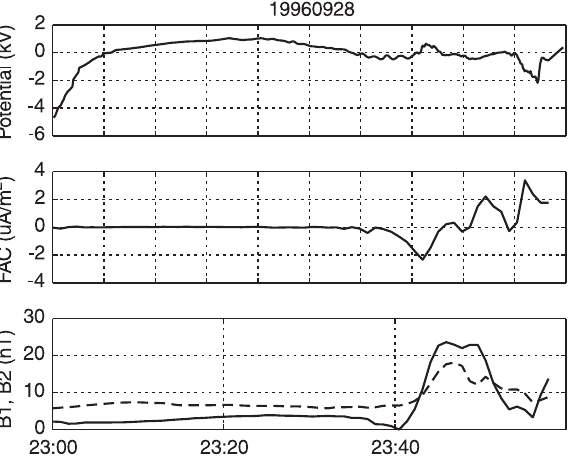
Fig. 3. Event 960928 23:35–23:45 UT (the BeF category). Since B not much smaller than B , the FAC estimate is not very reliable. The 1 potential is weak and has the wrong sign to support the upward extended U-shaped potential picture